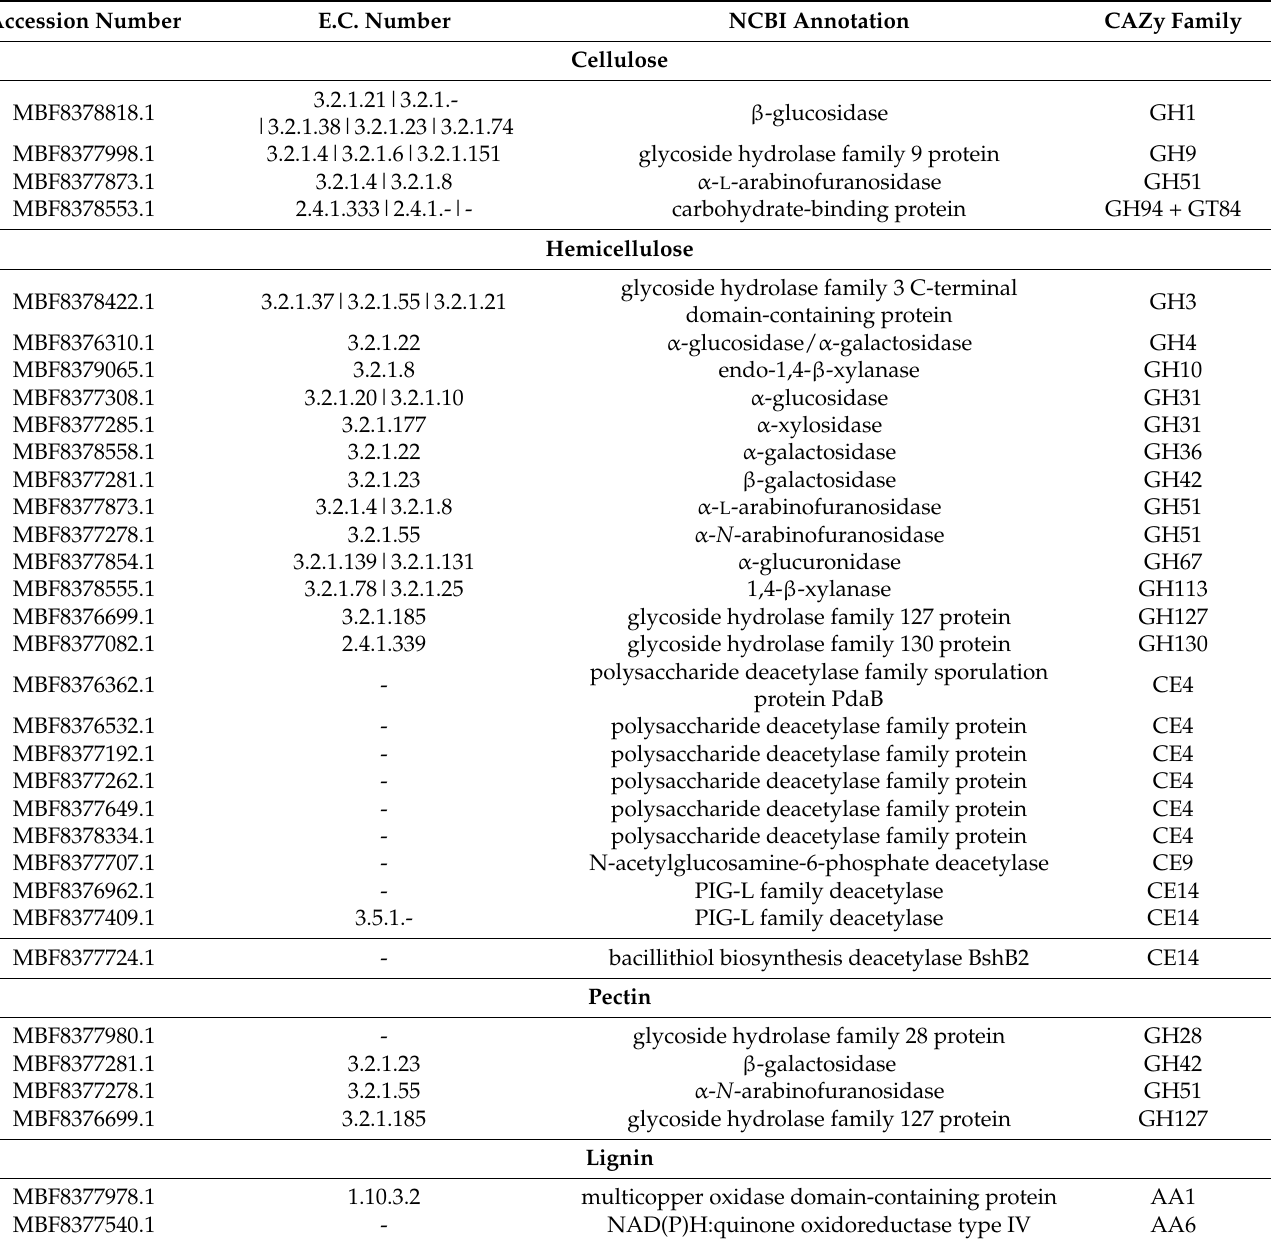
Table 1. A. mali FL18 predicted proteins containing CAZymes modules acting on lignocellulose components identified through dbCAN. Protein accession numbers, potential EC number(s), NCBI annotation and the CAZy family are